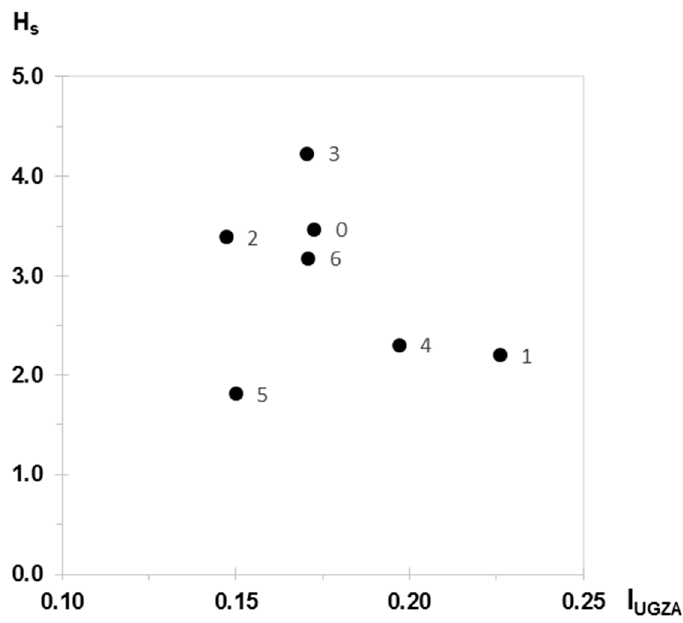
Figure 3. Scatterplot with the variables Shannon index (H s ) and Urban Green Zone Allergenicity Index (I UGZA ) for the current state of the urban park (0) and for six planting scenarios (values see Table 3). 4.